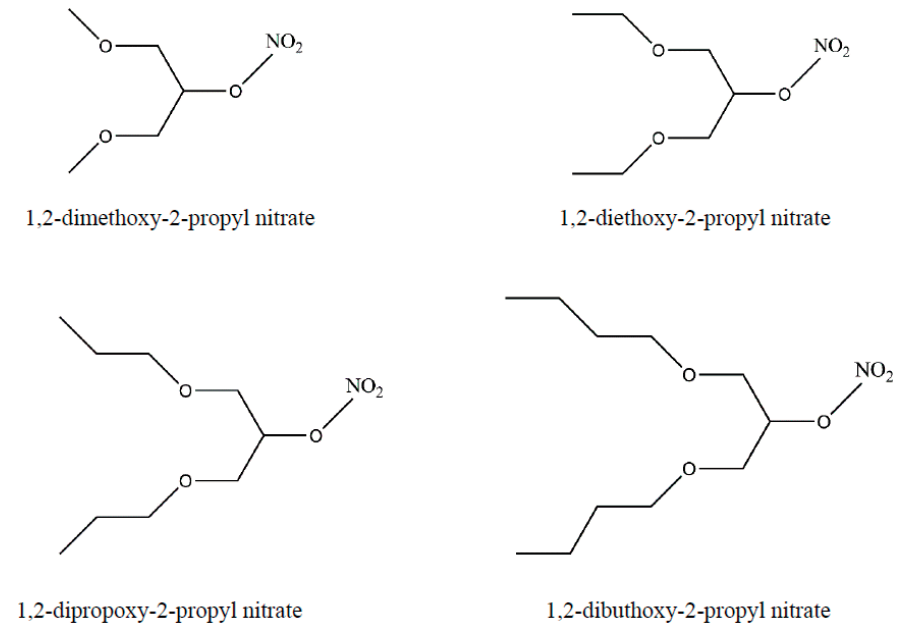
Figure 1. Structural formula of the new organic nitrates obtained from glycerin [35].